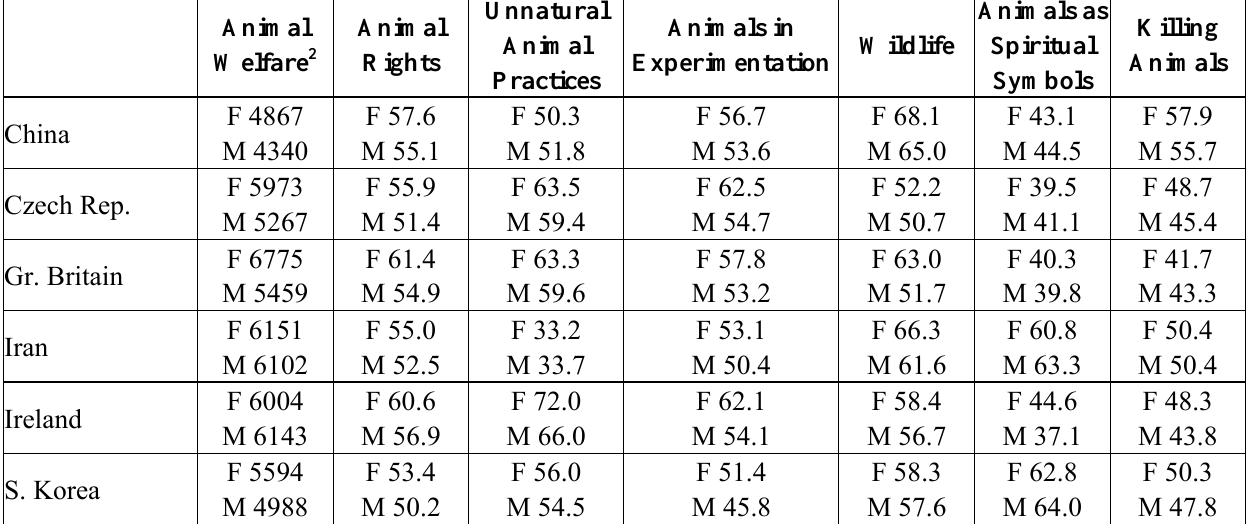
Table 3. Relationship between gender (F = female, M = male) and country in indices for Animal Welfare, Animal Rights, Unnatural Practices on Animals, Killing Animals, Animals in Experiments, Wildlife, Using Animals as Spiritual Symbols. High values mean greater concern for